Question: Draft a figure caption describing what is shown.
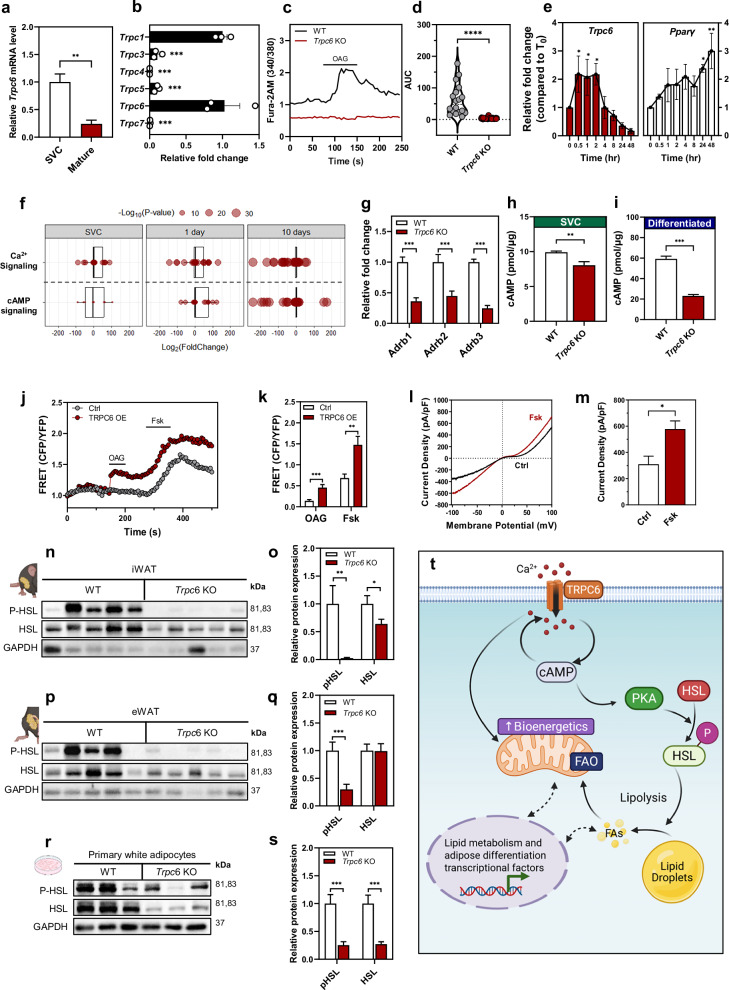
Answer: TRPC6–cAMP feedback loop coordinates adipocyte progenitor differentiation and lipid mobilization. a Relative mRNA levels of Trpc6 in stromal vascular cell (SVC) and differentiated primary white adipocytes ( n = 3 per group). b Heat map of relative mRNA levels of Trpc members in inguinal white adipose tissue (iWAT) normalized to Trpc1 expression ( n = 3). Traces (part c ) and quantification (part d ) of cytosolic Ca 2+ measured by Fura-2AM in wild-type (WT) and Trpc6 knockout (KO) SVCs in response to 1-oleoyl-2-acetyl- sn -glycerol (OAG) ( n = 18 and 39 cells for WT and Trpc6 KO SVCs, respectively). e Relative time-dependent mRNA levels of Trpc6 and Pparγ in primary white adipocytes after induction (compared with T 0 ) ( Trpc6 , n = 6; Pparγ , n = 5). f Box plot of differentially expressed genes in the cAMP signaling and Ca 2+ signaling pathways at different time points: SVC, 1 day, and 10 days after differentiation. g Relative mRNA levels of Adrb1 , Adrb2 , and Adrb3 in differentiated primary white adipocytes from WT and Trpc6 KO groups ( n = 9 per group). Cytosolic cAMP levels in SVCs (part h ) and differentiated primary white adipocytes (part i ). j , k FRET (Epac-S-H 187 probe)-based assay reveals TRPC6-induced cytosolic cAMP production. Forskolin (Fsk); ( n = 80–93 cells). l , m I–V curve and quantification of TRPC6 current in control and forskolin-stimulated conditions using a patch clamp ( n = 4 per group). Representative immunoblots and quantification of p-hormone-sensitive lipase (HSL) and HSL in iWAT (parts n and o ), epididymal WAT (eWAT) (parts p and q ), and differentiated primary white adipocytes (parts r and s ) (normalized to GAPDH) (iWAT and eWAT n = 10 per group and adipocytes n = 6 per group). t Schematic summary of TRPC6 function in Ca 2+ –cAMP–mitochondrial coupling during adipogenesis. Data are mean ± SEM; unpaired Student’s t test or two-way analysis of variance; * P < 0.05, ** P < 0.01, *** P < 0.001. AUC, area under the curve; FA, fatty acid;